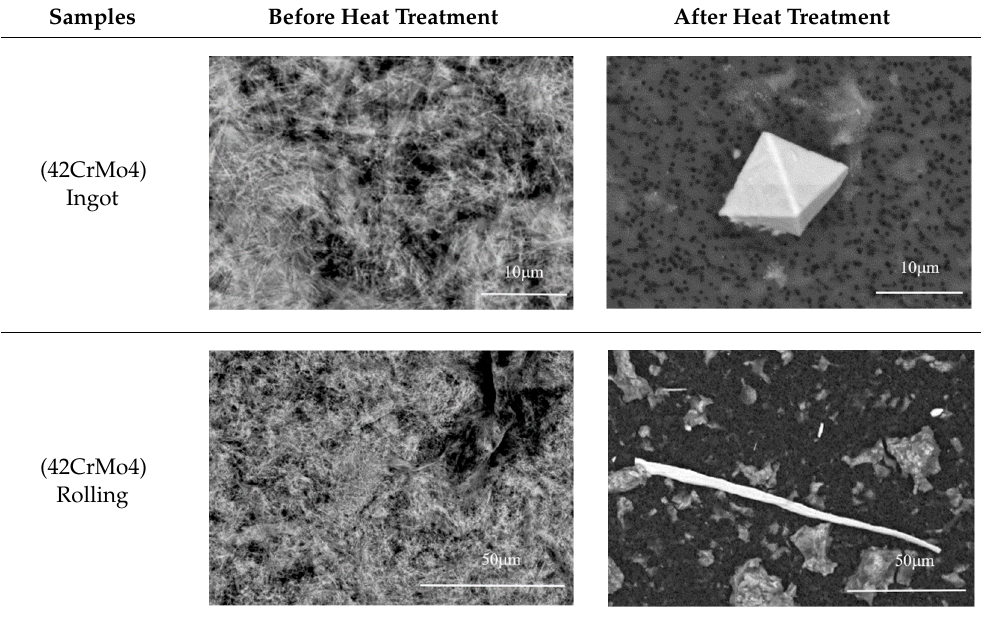
Table 7. Typical SEM images of inclusions on film filter after electrolytic extraction of 42CrMo4 steel samples (0.42% C) without and with heat treatment.